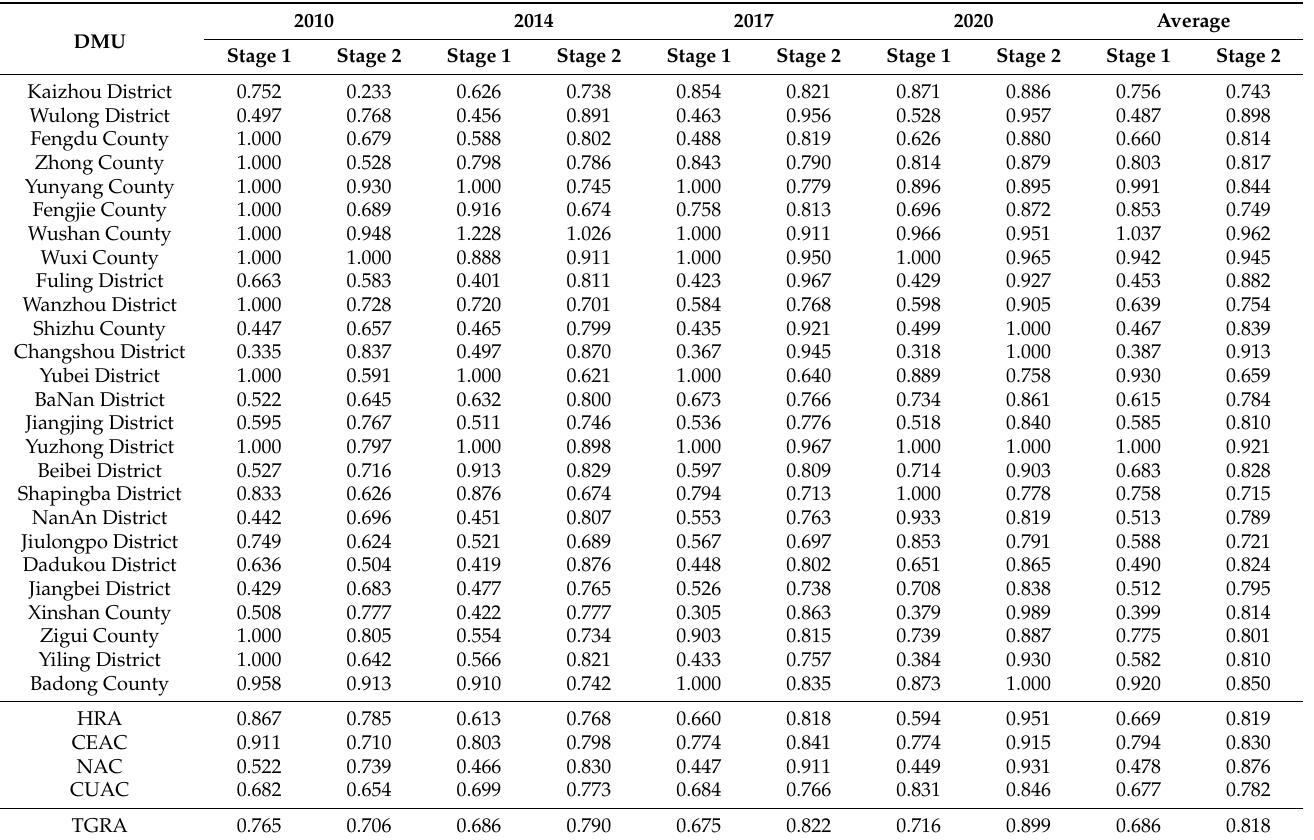
Table 4. Two-stage efficiency of EWP in the TGRA from 2010 to